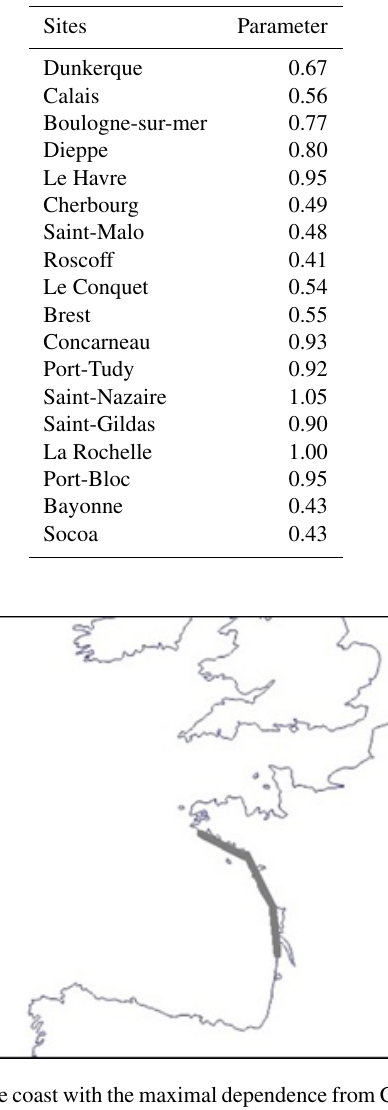
Table 4. Clayton parameters for the different sites.